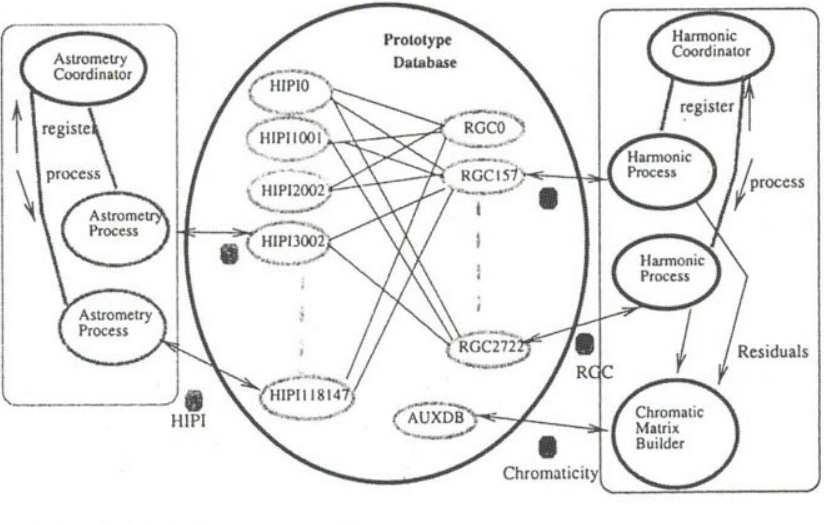
Fig. 2. Prototype